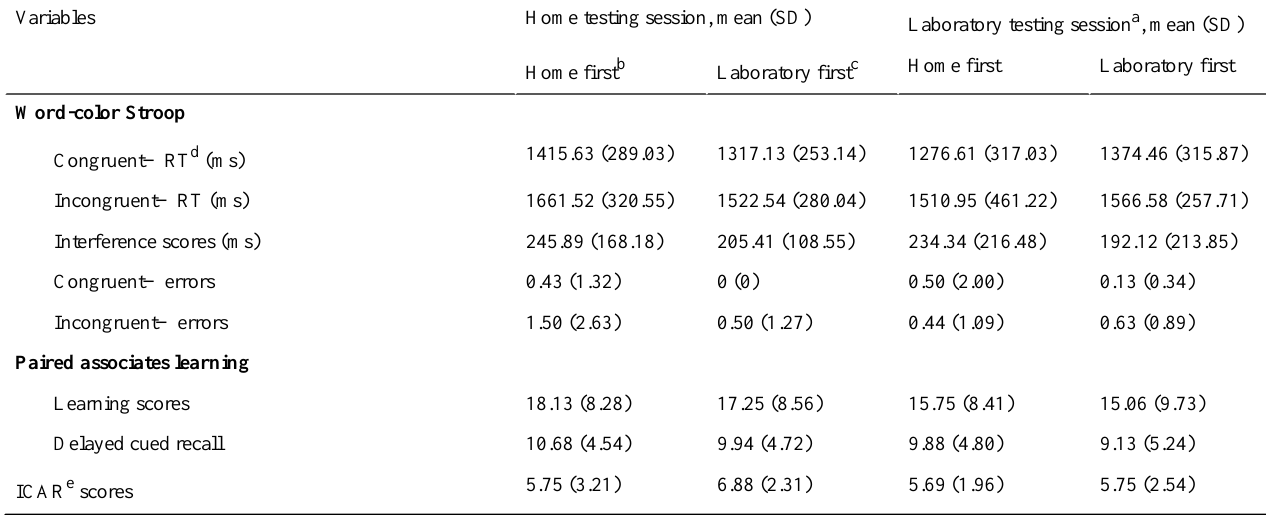
Table 2. Mean performance on experimental tasks as a function of testing environment and order of testing environment (SDs in